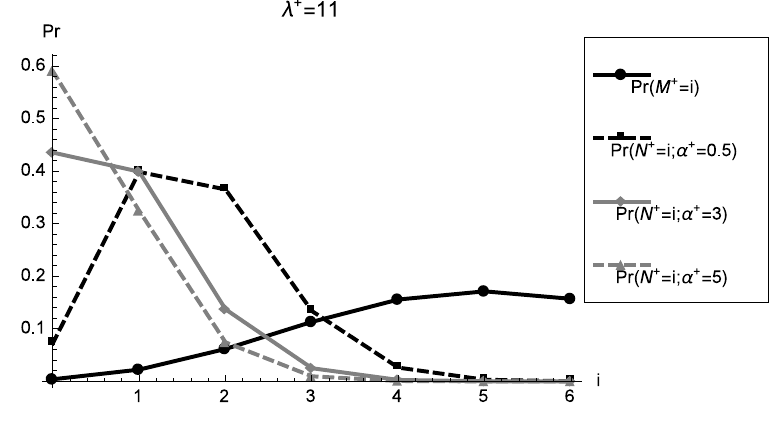
Figure 14 { Probability functions of M + and N + for (cid:21) + = 7 and (cid:11) + 2 f 0 : 5 ; 3 ; 5 g .